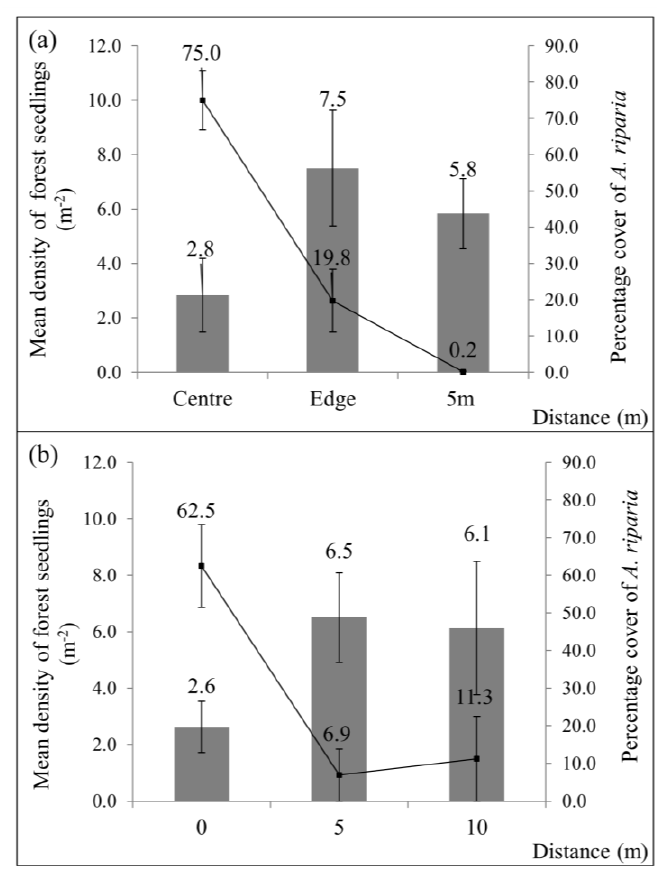
Figure 3: (a) The graph of the mean density of seedlings of forest species and the percentage cover of A. riparia vs the distance from the forest gaps (b) The graph of the mean density of seedlings of the forest species and the percentage cover of A. riparia vs the distance from the